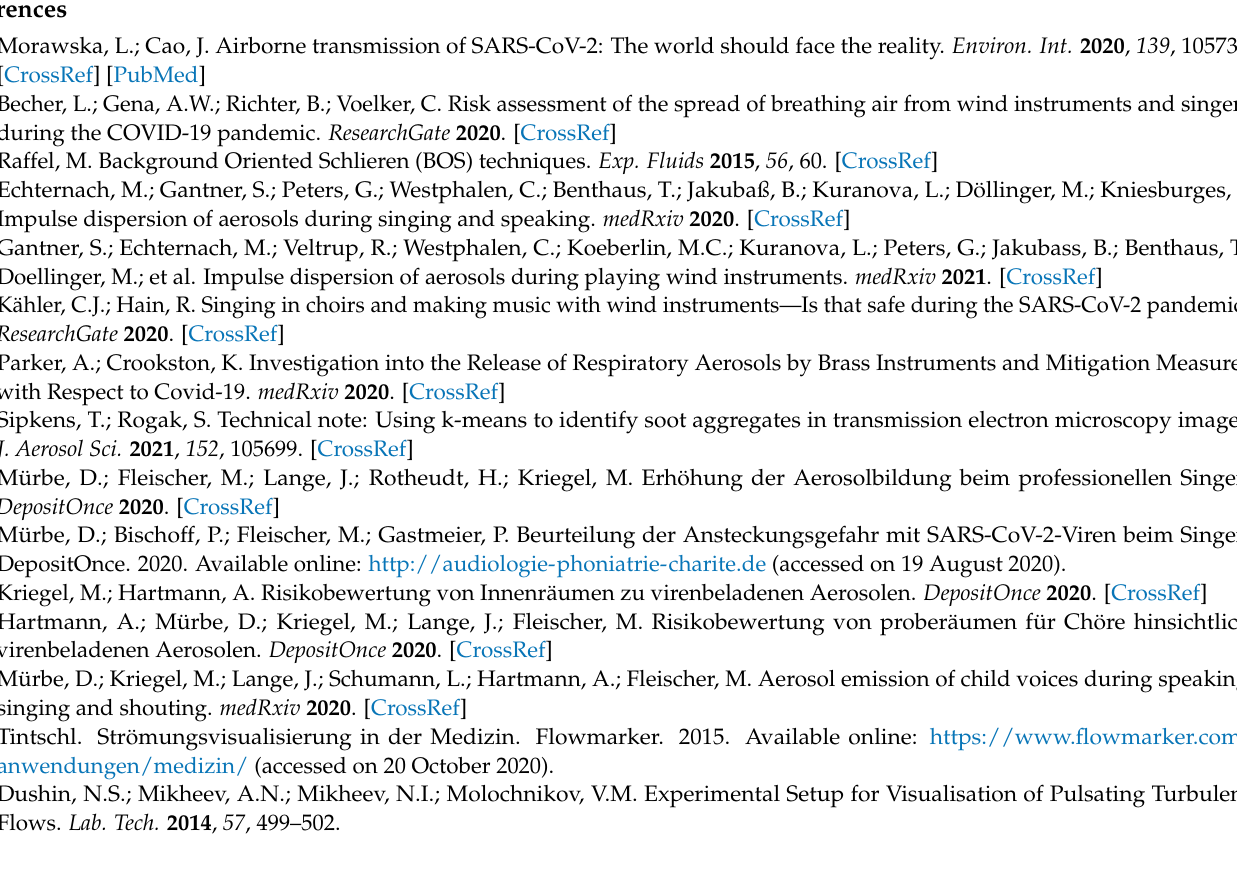
Figure A10. Example measurements of a bass clarinet with the impact of a person passing by the sensor.